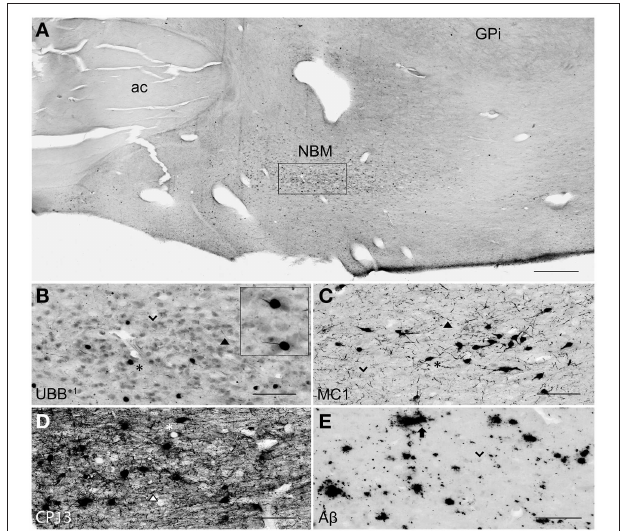
FIGURE 6 | UBB + 1 and AD neuropathology (NFTs, NTs, and A β plaques) in the human NBM. (A) Representative photomicrograph of a 50 µ m-thick coronal section from the NBM of patient #4 (Braak 3). (B–E) Higher magnifications of the boxed region in (A) incubated with four antibodies against (B) UBB + 1 , (C) pre-tangles material (MC1), (D) tangles (CP13), and (E) A β plaques. The cholinergic cells of the NBM are shown by an arrowhead . The nucleus is significantly affected by both tau pathology [neuronal staining ( asterisk ) and NTs ( filled triangle )] and extracellular A β accumulation (arrow) . UBB + 1 expression (asterisk) is found in cholinergic cells of the NBM. Bars: (A) , 1mm, (B–E) , 200 µ m. ac, anterior commissure; GPi, globus pallidus internal segment; NBM, nucleus basalis of